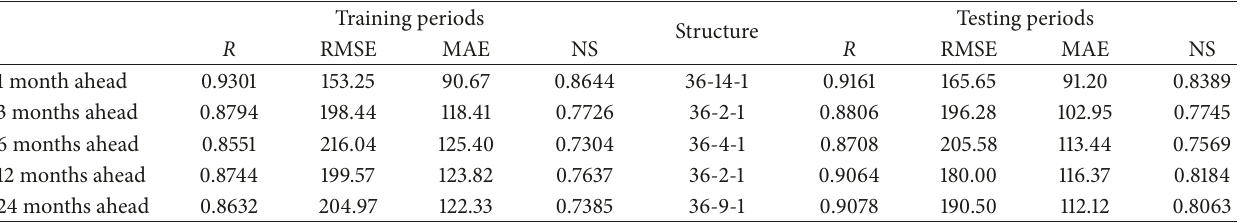
Table 4: Performance statistics of the ANN model with three input variables (runoff, precipitation, and air temperature) during the training and testing periods for 1-, 6-, 12-, and 24-month-ahead runoff forecasting in the YARHR.